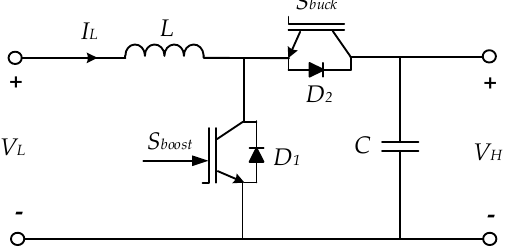
Figure 1. Conventional bidirectional DC-DC converter.